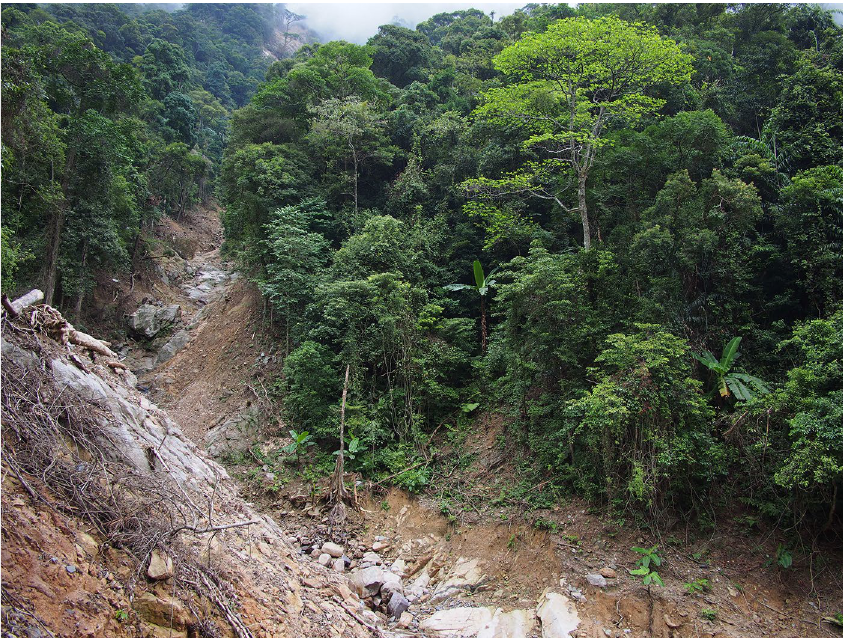
Figure 1. One of numerous landslides in the gibbon forest of Bawangling three months after Super Typhoon Rammasun, taken on 24 October 2014. Photograph taken by